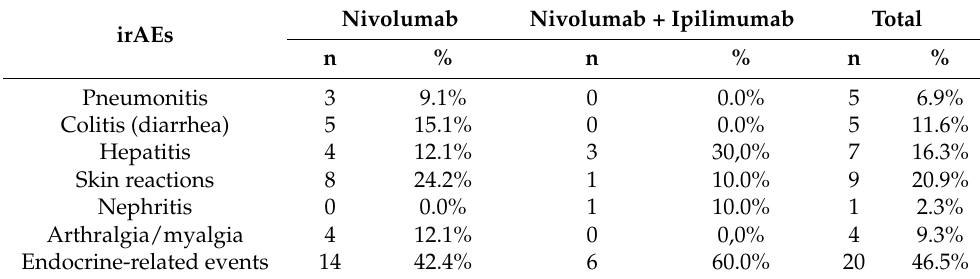
Table 2. Comparison between irAEs in mRCC patients treated with nivolumab or with nivolumab and